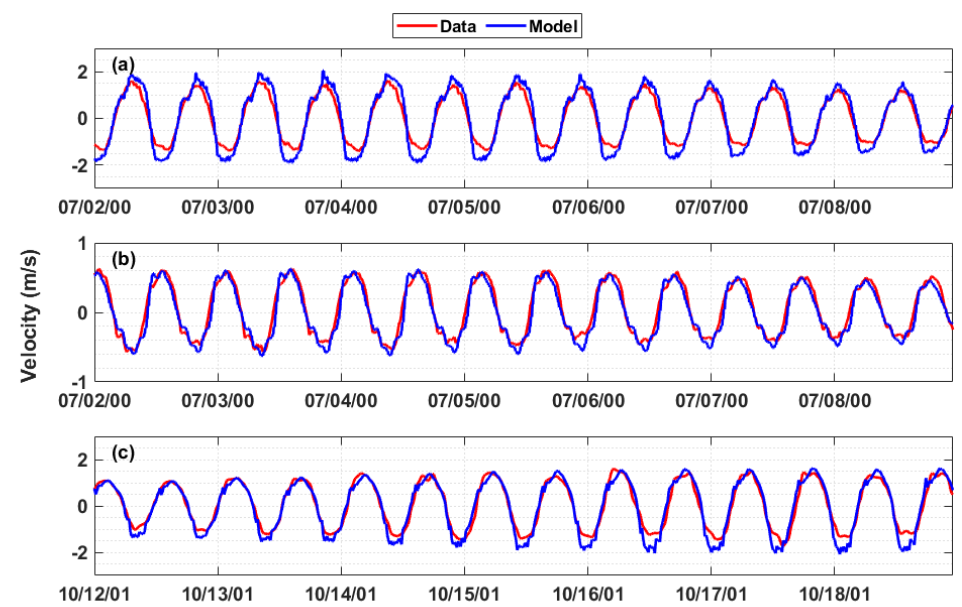
Figure 5. Comparison of the modeled and observed depth-averaged tidal currents (principal component) at ( a ) EP0003, ( b ) EP0004, and ( c ) J02. A positive value denotes the flood current. Station locations are shown in Figure 1. Table 3. Error statistics of the current predictions at stations EP0003, EP0004, and J02.